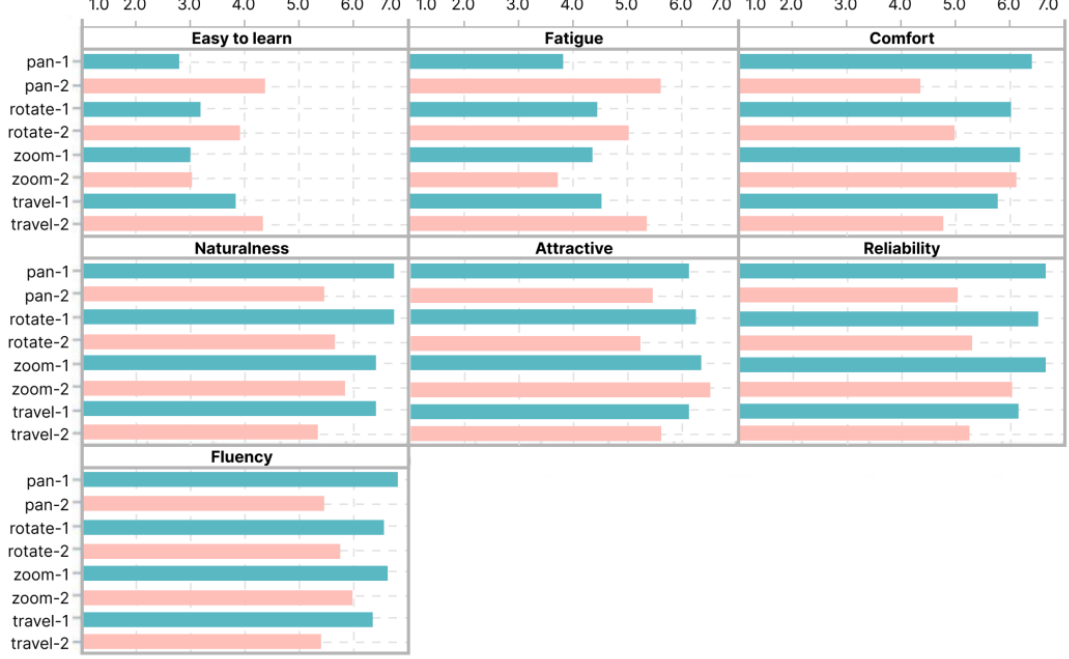
Figure 8. Results of the seven-point Likert